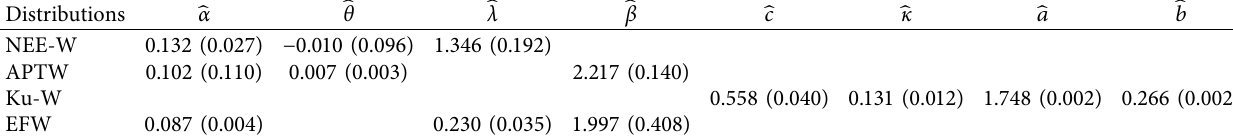
Figure 8: Using the Netherlands COVID-19 data and fitting the PP and Kaplan–Meier survival plots. Table 7: The numerical values of the proposed and compared distributions using the ML technique.